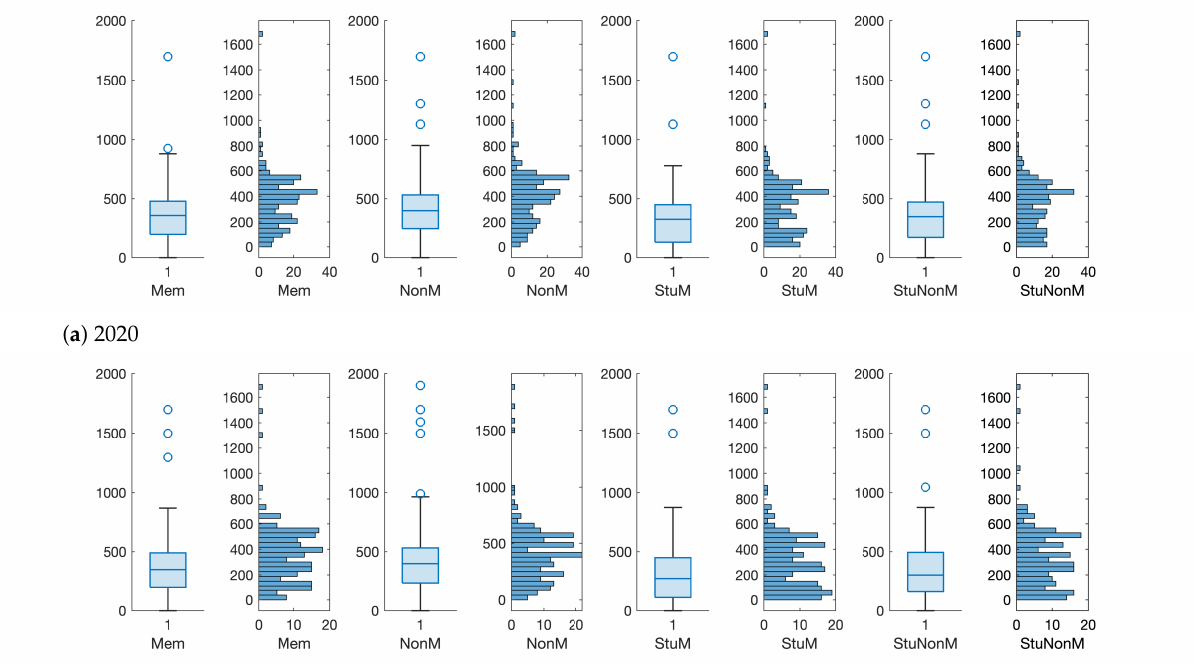
Figure A6. Distributions of the four types of registration fees of virtual conferences held in ( a ) 2020 and ( b ) 2021.